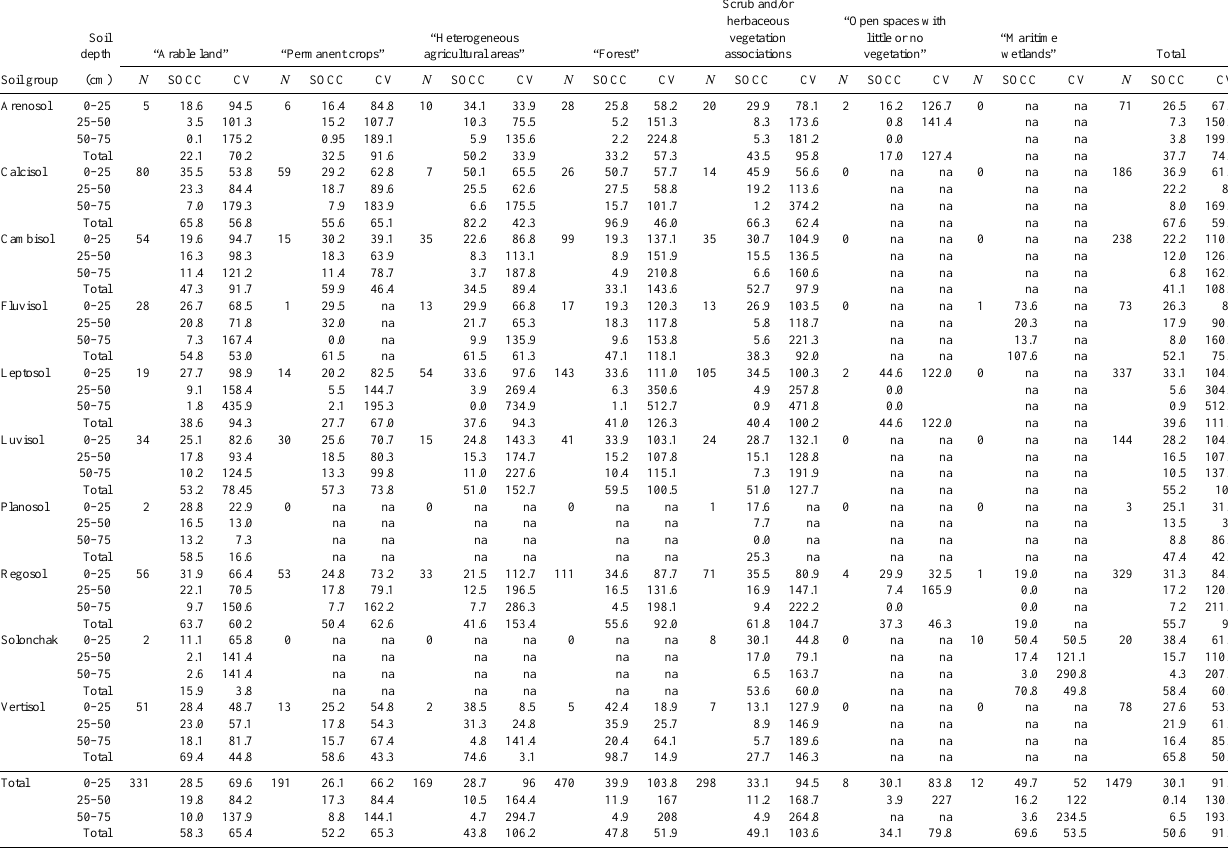
Table 2. Carbon stocks for land use soil combinations at different soil depths (0–25, 25–50 and 0–75m) (Mgha − 1 ). N : number of values, SOCC: Soil organic C content, CV: coefficient of variation, na: insufficient number of samples to provide statistics (not